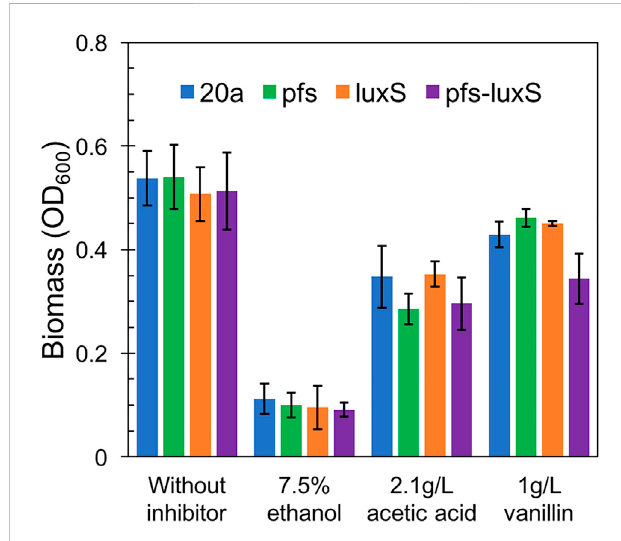
FIGURE 7 Growth of planktonic cells in fl asks under ethanol, acetic acid, and vanillin addition, OD 600 was measured at 12 h. The statistic p -value > 0.05 among each group.